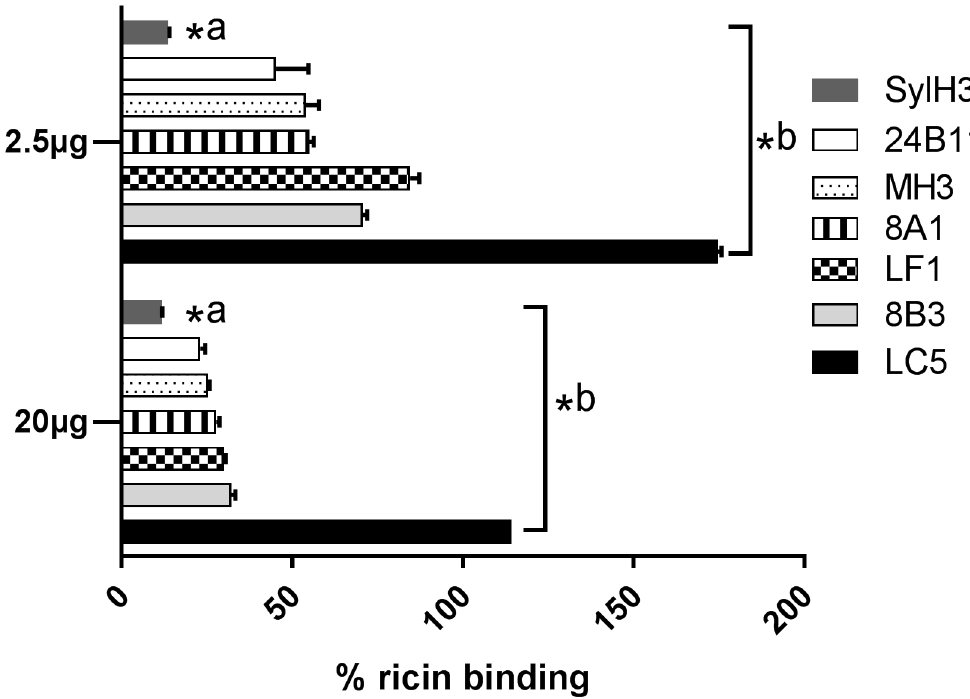
Fig 5. Interference with ricin-receptor interactions by anti-RTB mAbs. Biotin-labeled ricin (50 ng/ml) was mixed with indicatedmAbs (2.5 μ g or 20 μ g) and then appliedto 96-wellmicotiter plates coated with ASF (4 μ g/ml), as describedin Material and Methods. Biotin-ricinbindingto ASF was detected with avidin-HRPand TMB substrate. Biotin-ricinbindingwas then normalized to biotin-labeled ricin in the absenceof antibody.The enhanced ( > 100%)ricin-capture observedin Panel A (at the equivalent of a 2:1 mAb:toxin molar ratio) but not in panel B (at 16:1 mAb:toxin molar ratio) is likely due to a bridgingeffect in which one arm of LC5 associateswith ricin bound to ASF, while the other arm of LC5 captures ricin in solution.At higherLC5 stoichiometric ratios when antibody is in excess such bridgingdoes not occur becausesolublericin is saturated with unboundLC5. The data represent a single experiment in which each sample was done in triplicate (mean ± SD) and repeatedat least three times. The asterisks indicatetwo levels of statistical analysisperformed on this assay: * , a indicatesthat the inhibitoryeffect of SylH3 on ricin bindingwas significantlygreater ( p < 0.05) that the other mAbs tested; * , b indicatesthat the inhibitoryeffect of SylH3, 24B11, MH3, 8A1, LF1 and 8B3 were significantly greater ( p < 0.05) than